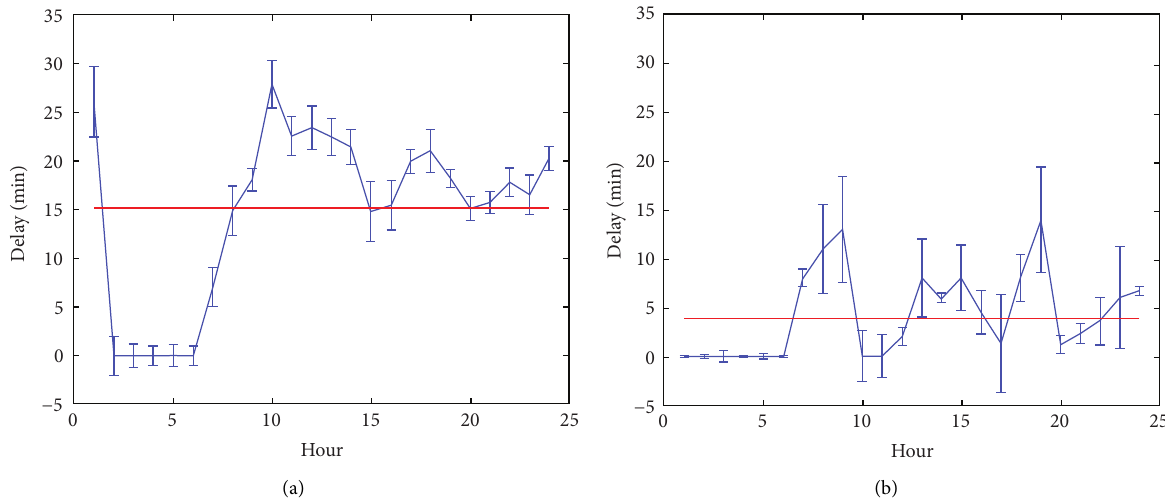
Figure 9: Error bars of (a) Atlanta Airport (ATL) and (b) Atlantic City Airport (ACY).